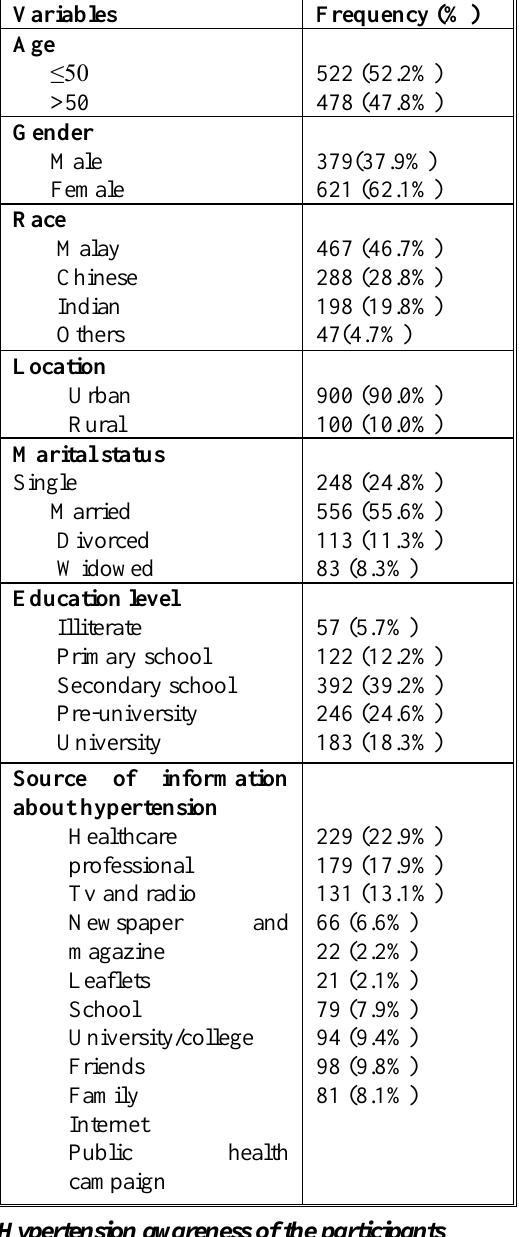
Table 1. Sociodemographic characteristics of hypertensive patients who responded to the survey (n = 1000)